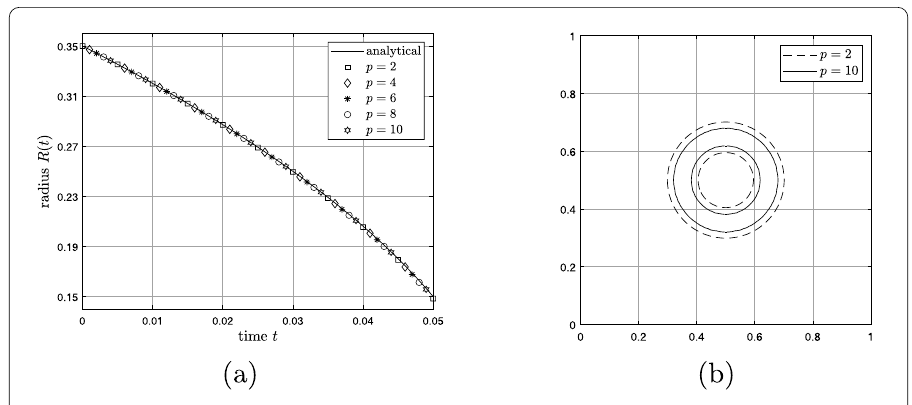
Figure 7 ( a ) Evolution of the radius of the interfacial circle for different p . ( b ) Interfacial layer (from φ = –0.95 to φ = 0.95) at t = 0.05 for p = 2 and 10